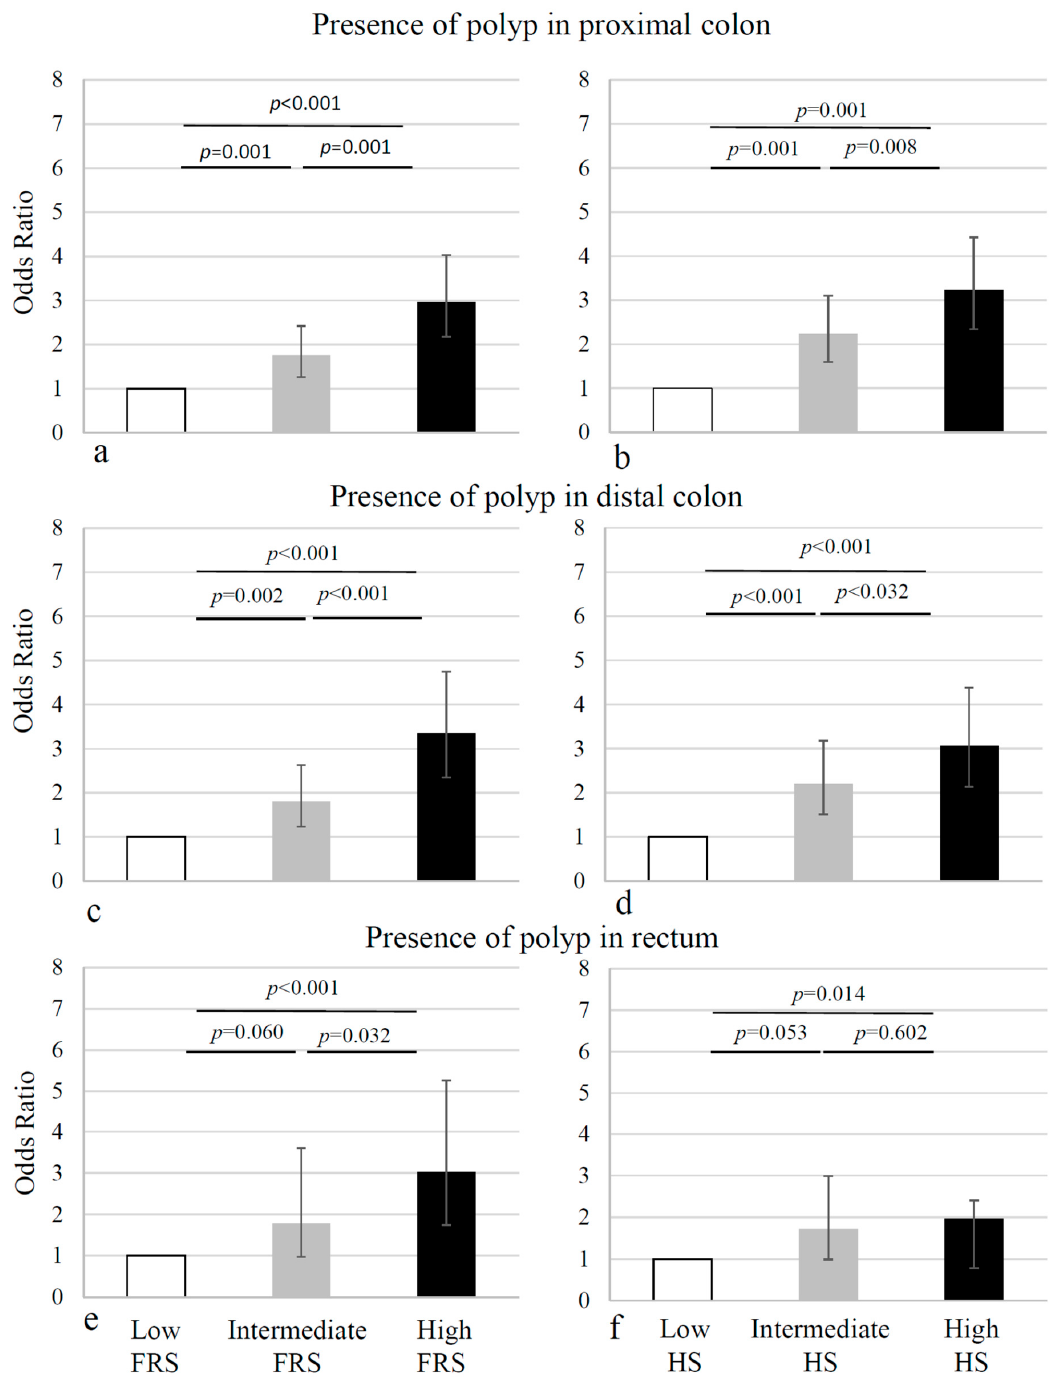
Figure 2. Site-specific odds ratios for any adenoma and advanced neoplasia. Odds Ratios (ORs) for having lesions in the proximal or distal colon increased in the intermediate and the upper Framingham Risk Score (FRS) and the Heart Score (HS) of the European Society of Cardiology tertiles, respectively ( a – d ). The prevalence of adenomas in the rectum was much lower than in the colon. The difference in the distribution of the rectal lesions, according to the cardiovascular risk, was more pronounced in the FRS ( p < 0.001) than in the HS tertiles ( p = 0.039) ( e , f ).